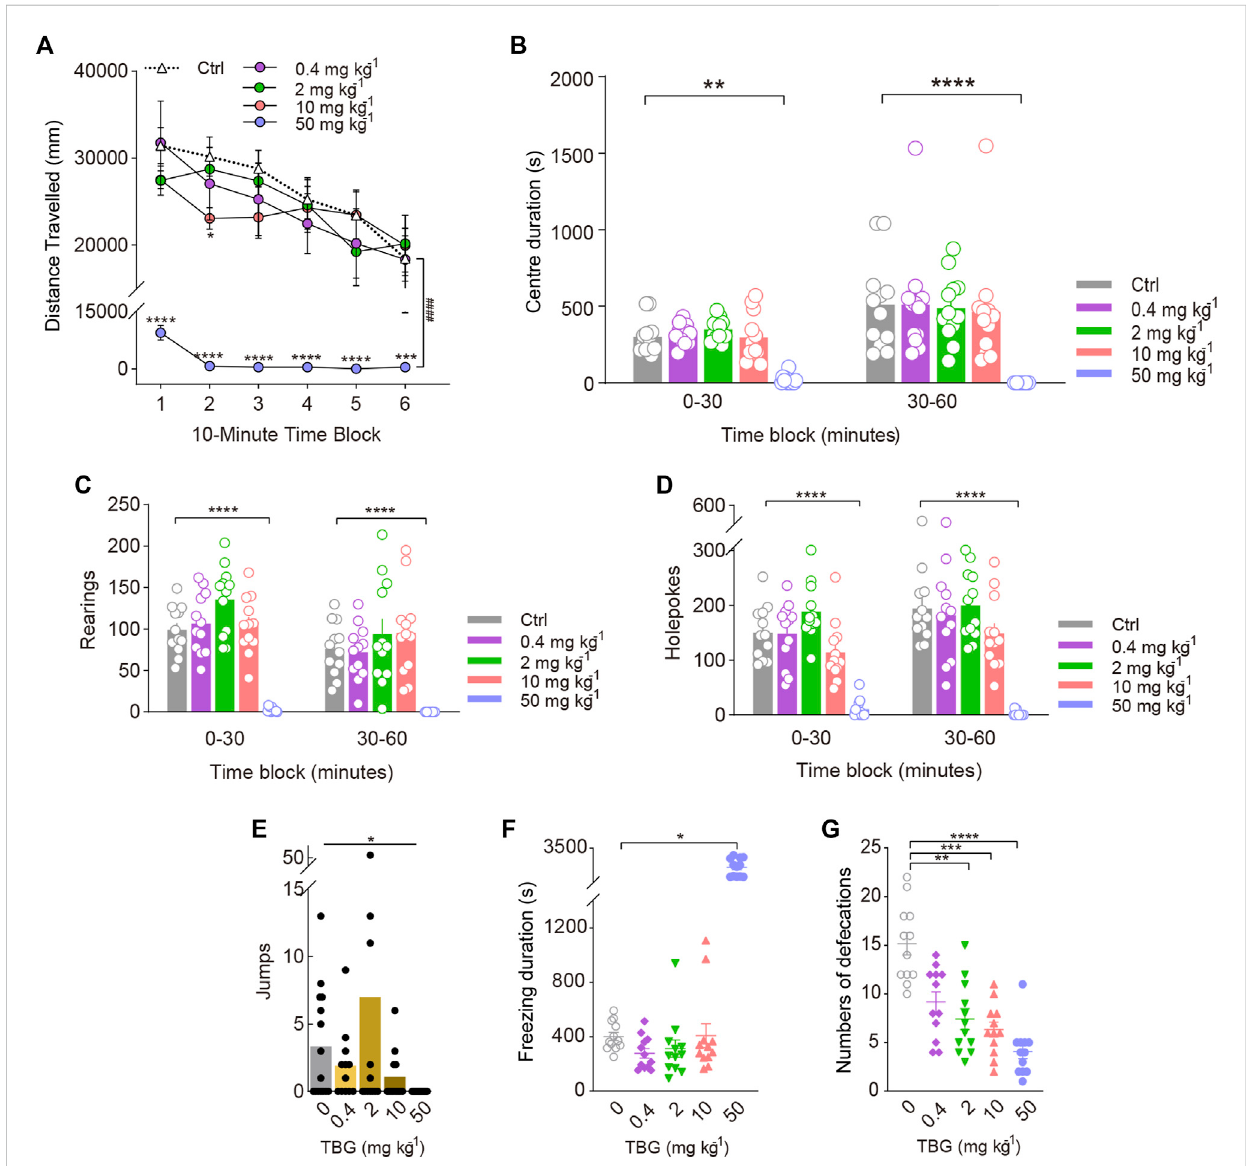
FIGURE 6 Behavioural changes in locomotor and exploratory behaviour of mice induced by the putatively nonhallucinogenic 5-HT 2A -selective agonist TBG. The effect of TBG on (A) distance travelled (in mm), (B) centre duration (in seconds), (C) the total number of rearing behaviours ( rearings ), (D) the total number of hole explorations ( holepokes ), (E) the total number of jumps ( jumps ), (F) freezing duration (in seconds), and (G) the total number of defecations. Data are shown as the means ± SEM for consecutive 10-min (A) and 30-min intervals (B – D) . n = 12 mice per group. Statistical tests includedtwo-wayrepeatedmeasures (A) ,andtwo-way (A – D) ANOVAfollowedbyDunnett ’ smultiplecomparisonstest.Kruskal-WallisHtestwithDunn ’ s multiple comparisons tests (E – G) comparing treatment groups to the control group. * p < 0.05, ** p < 0.01, *** p < 0.001, **** p < 0.0001, and #### p <